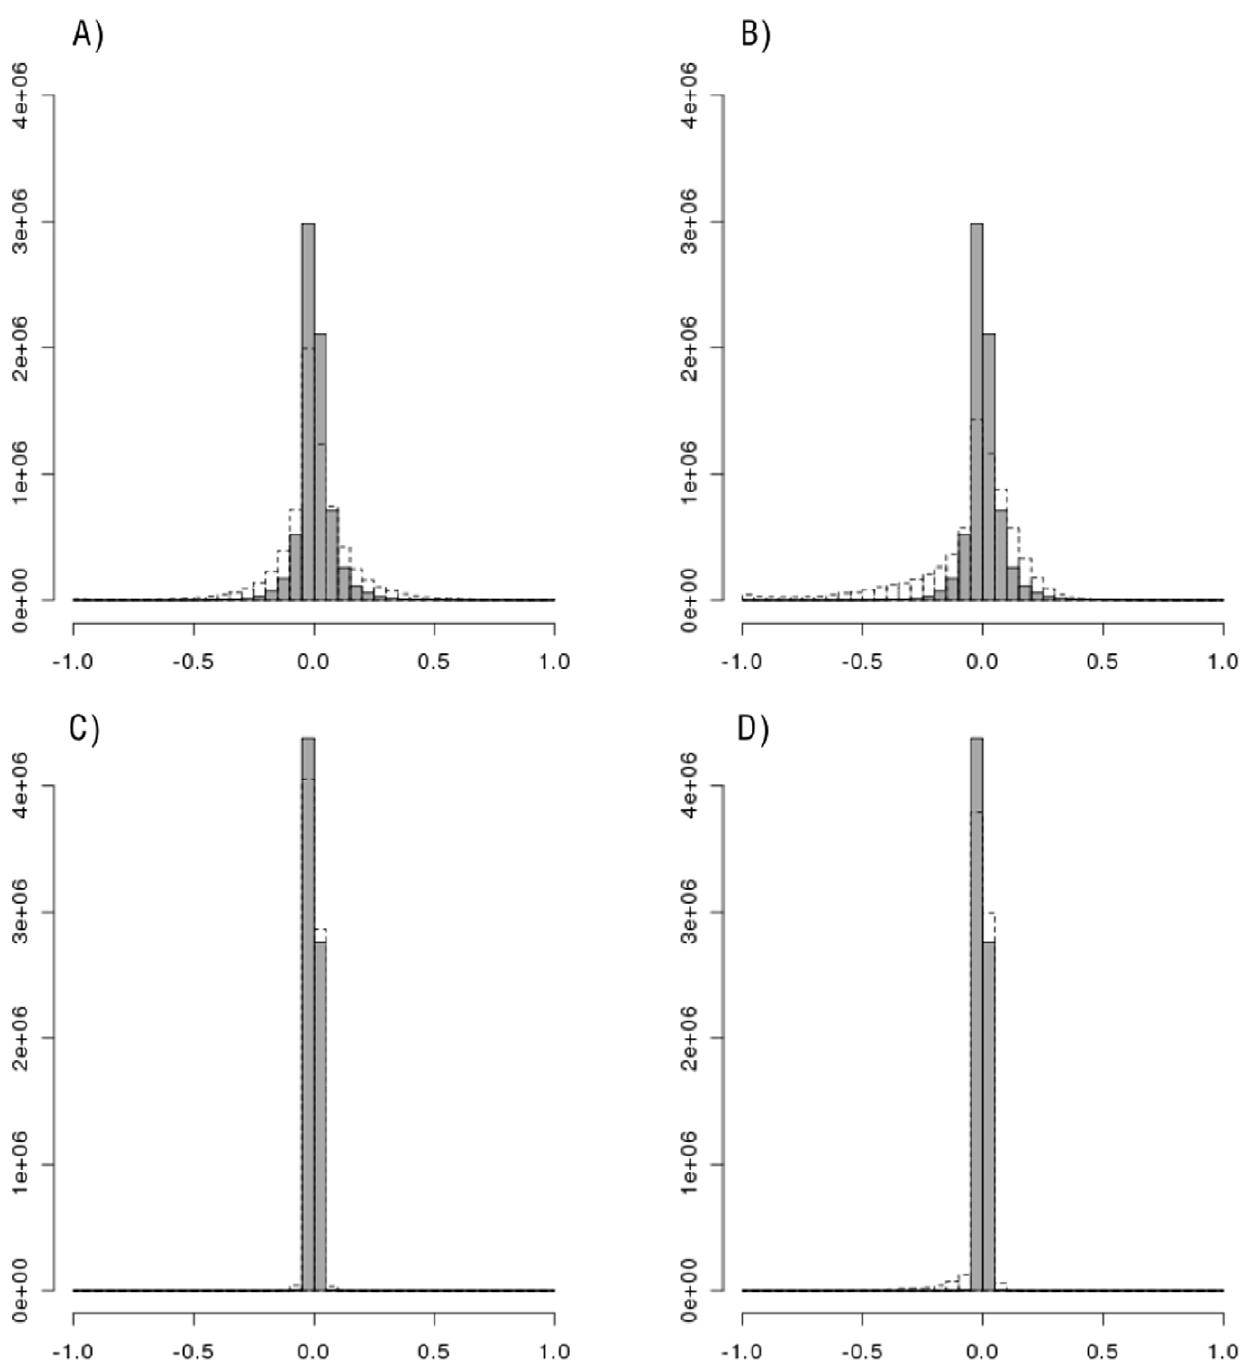
Figure 3. Histograms of the change in LD for each pair of SNPs in Gene Region 2. Histograms of the change in simulated LD from original LD for each pair of SNPs in Gene Region 2 (LD simulated – LD HapMap ). A) D’, Resampling (gray) vs Hapgen (dotted); B) D’, Resampling (gray) vs HapSim (dotted); C) r 2 , Resampling (gray) vs Hapgen (dotted); D) r 2 , Resampling (gray) vs HapSim (dotted).